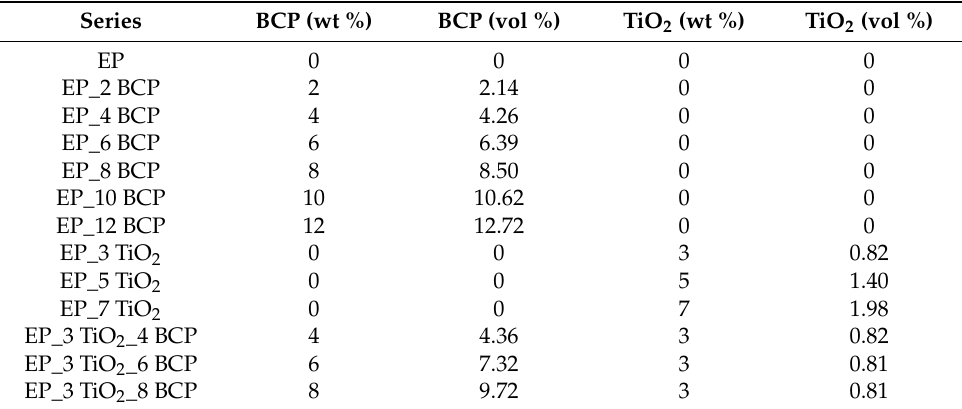
Table 1. Composition and nomenclature of bulk epoxy based